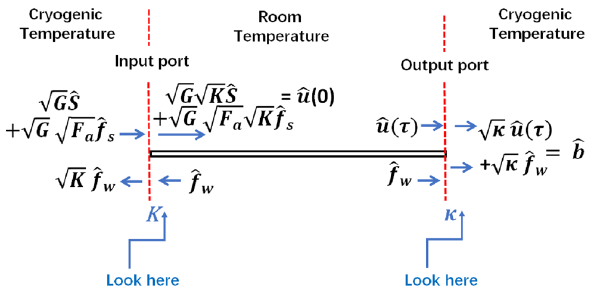
Figure 5. The fields operators and the input-output relations at the waveguide